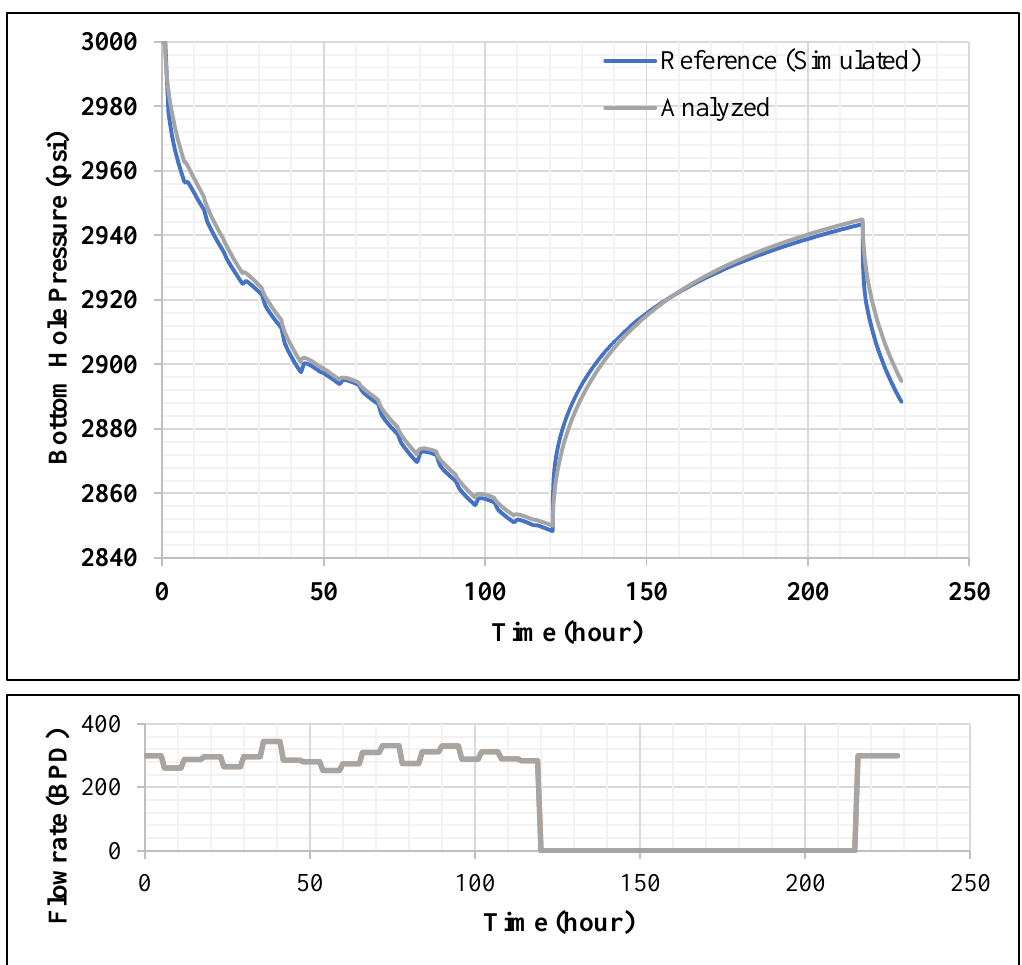
Figure 3. Analysis of simulation result of the synthetic hydraulic fractured model in Cartesian Plot.